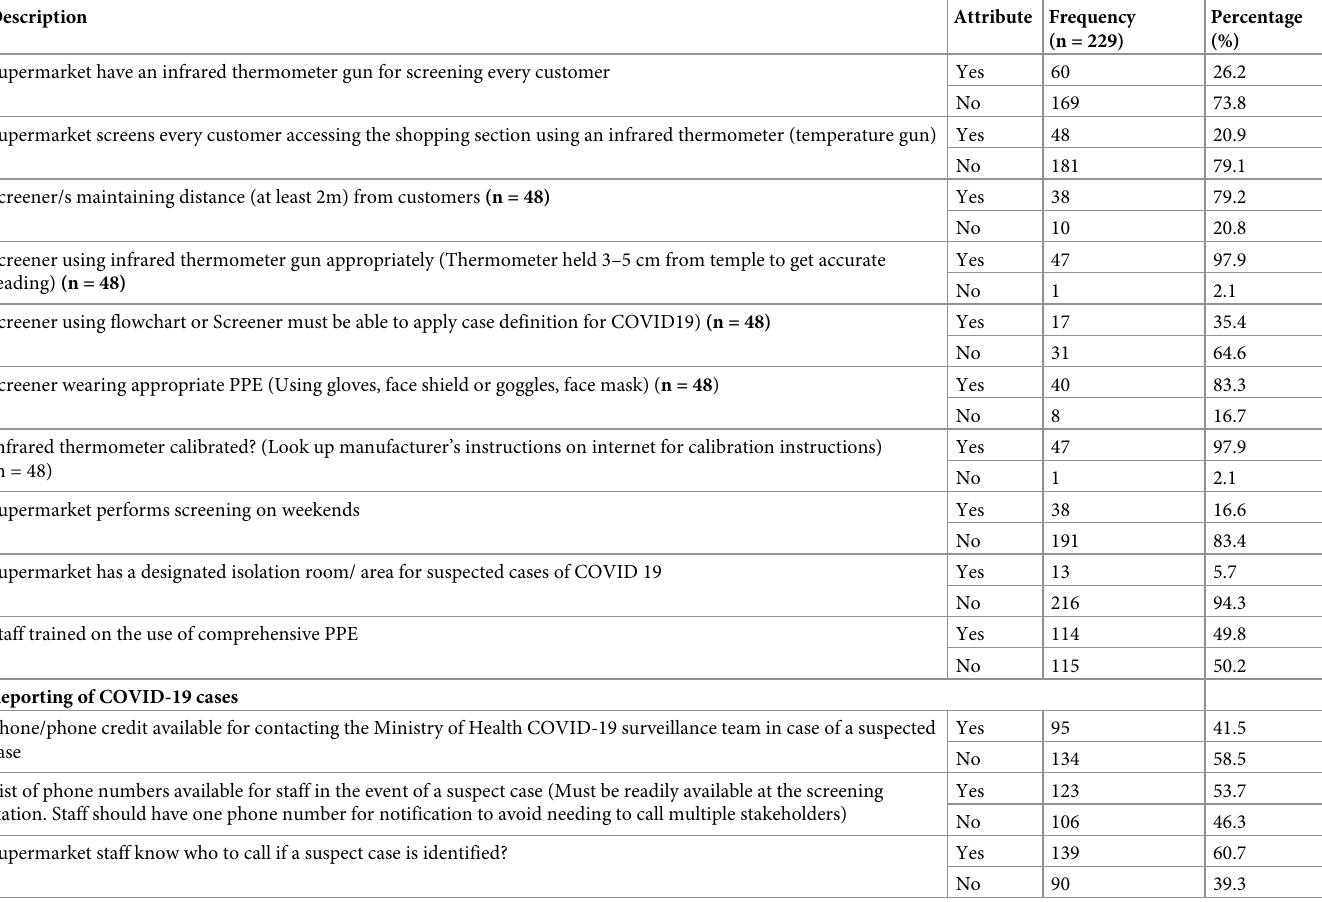
Table 4. Temperature screening and reporting of suspected COVID-19 cases in supermarkets in Kampala Capital City and Mukono Municipality, Uganda. Description Attribute Frequency